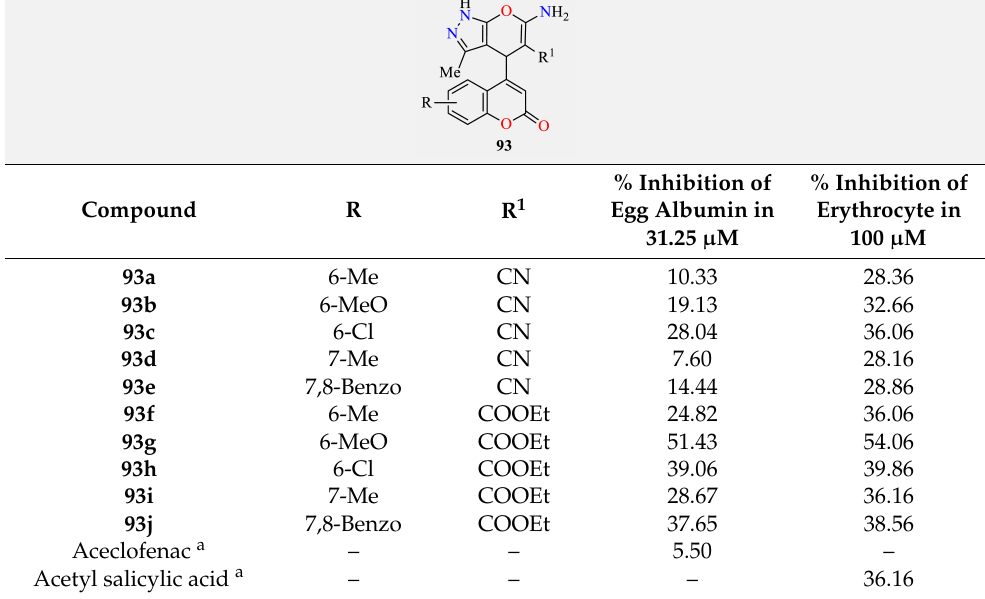
Table 48. Anti-inflammatory activity of 4-coumarinylpyrano[2,3- c ]pyrazoles 93